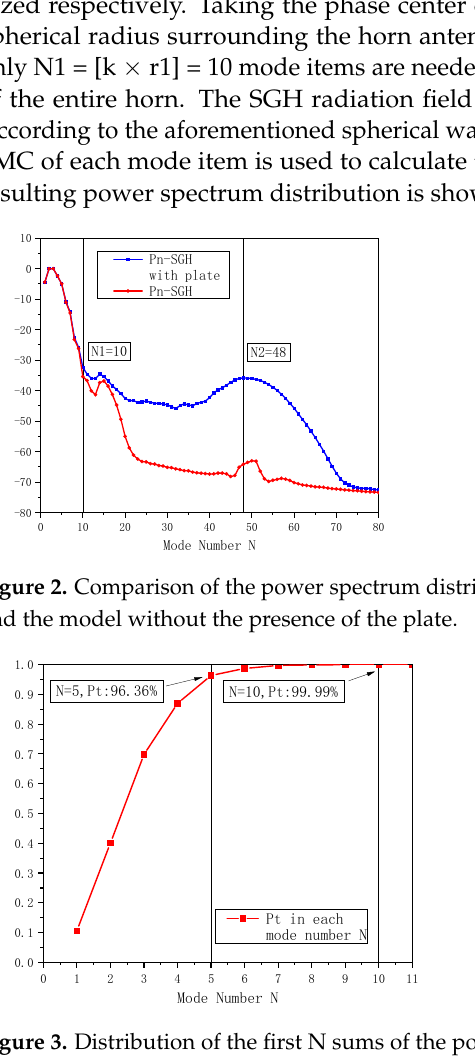
Figure 3. Distribution of the first N sums of the power spectrum of a single horn antenna.